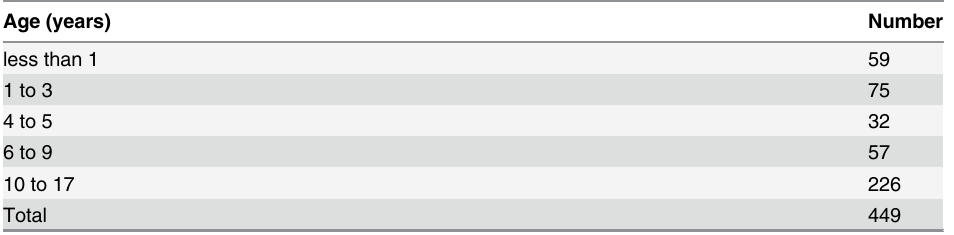
Table 1. Patients with full data set initiated on ventilatory support by age.